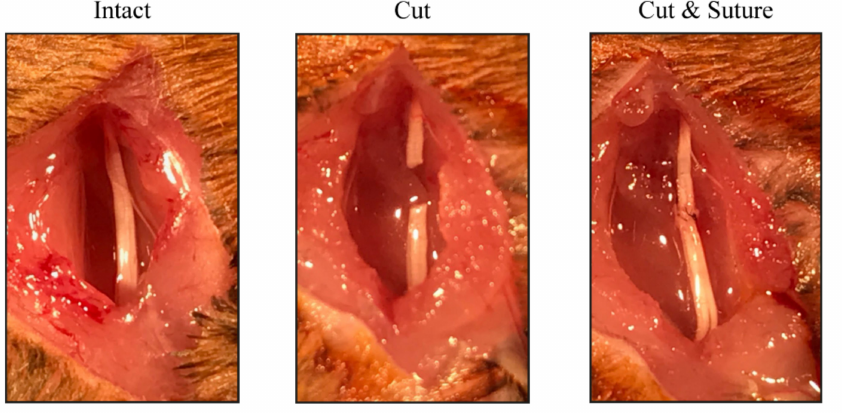
Figure 1. Illustration of the cut-and-suture surgical approach. The right sciatic nerve was exposed, cut at 43 mm from the tip of the 3rd toe and repaired by epineurial